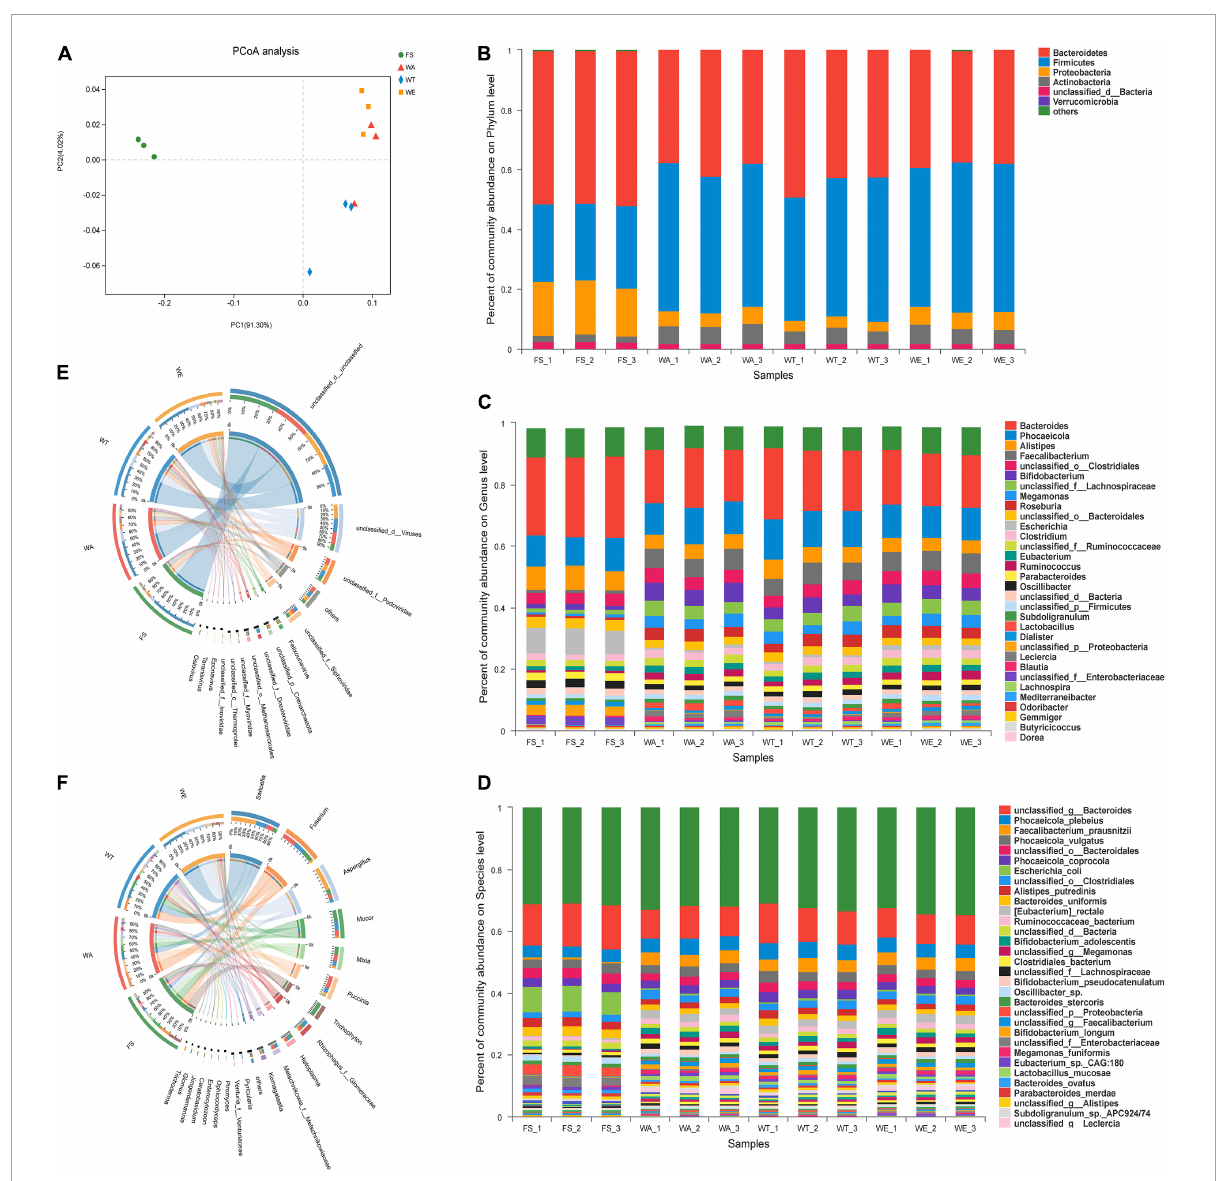
FIGURE1 The microbial community distribution and relative abundance of bacteria, fungi and viruses in the cereals mixture and the community differences among groups. (A) Principal coordinates analysis (PCoA) of bacteria, (genus level). Some classes with less than 1% abundance were summarized as "Other." (B) Distribution and relative abundance of bacterial communities at the phylum level. (C) Distribution and relative abundance of bacterial communities at the genus level. (D) Distribution and relative abundance of bacterial communities at the species level. (E , F) Distribution and relative abundance of fungi and viruses at the genus level,